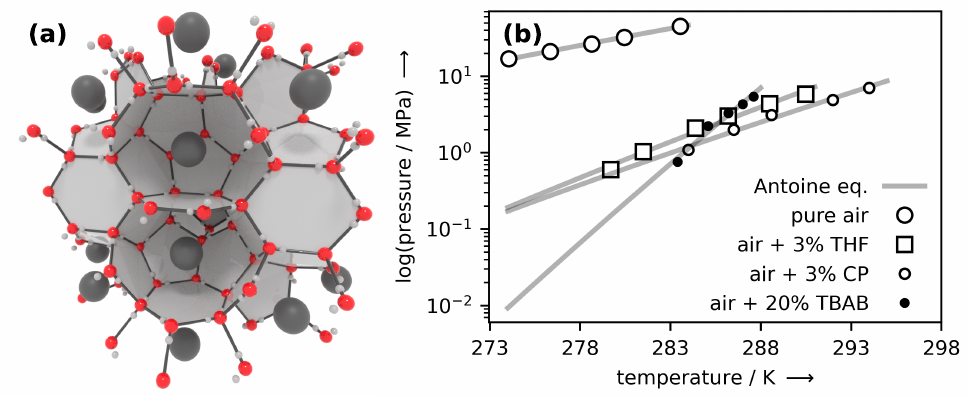
Figure 1. ( a ) Artistic illustration of the molecular structure of SA, i.e., air hydrate. The large grey balls denote air molecules (N 2 and O 2 ), the red balls denote the oxygen atoms of water molecules which form a hydrogen-bonded network of cavities around the air molecules. ( b ) Hydrate–liquid–vapor equilibrium data for pure air hydrate (data from Mohammadi et al. [25]) and for hydrates of air with the growth-promoting substances Tetrahydrofuran (THF), Cyclopentane (CP), Tetrabutylammonium bromide (TBAB) (data from Yang et al. [26]). The solid grey lines fit the data and denote the phase boundary above which the hydrate is thermodynamically stable (also see Lipenkov and Istomin [27] and Mohammadi and Richon [28] for a discussion of the phase